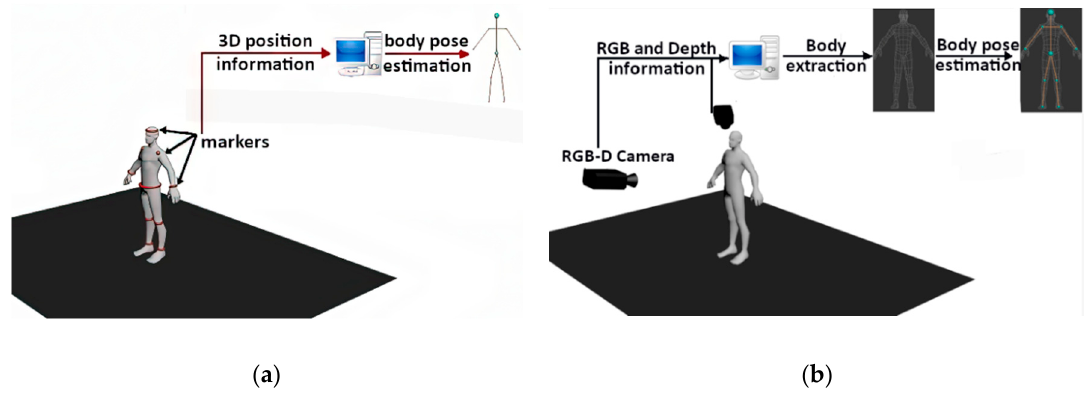
Figure 1. ( a ) Marker and ( b ) markerless system.